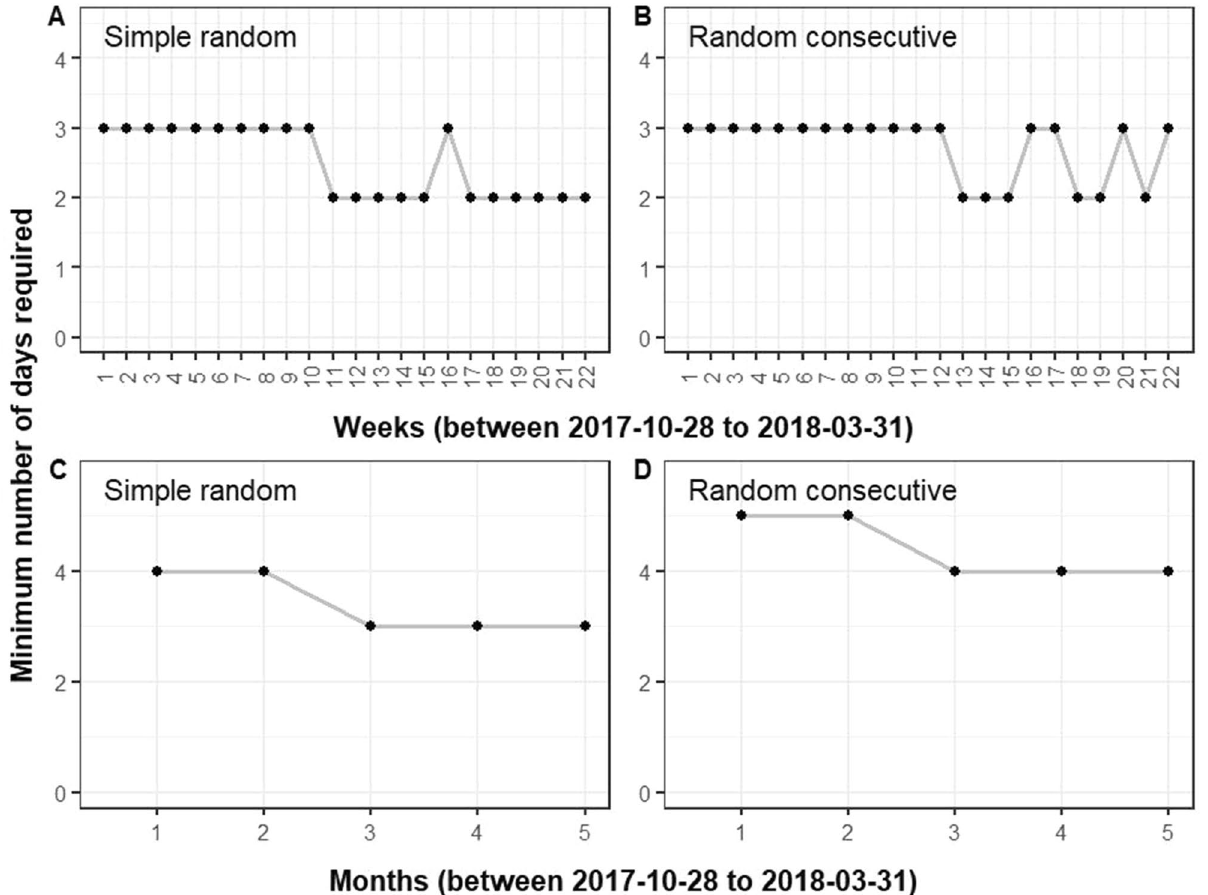
Figure 2. Minimum number of measurement days required to reliably estimate the mean daily step count for the 22 weekly time windows (N = 212,048) and five monthly time windows (N = 112,865) between 2017-10-28 and 2018-03-31. ( A ) simple random days in weekly time windows; ( B ) random consecutive days in weekly time windows; ( C ) simple random days in monthly time windows; ( D ) random consecutive days in monthly time windows. Figures were generated using R software version 3.6.1. (R Core Team (2020). R: A language and environment for statistical computing. R Foundation for Statistical Computing, Vienna, Austria. URL https:// www.R- proje ct.